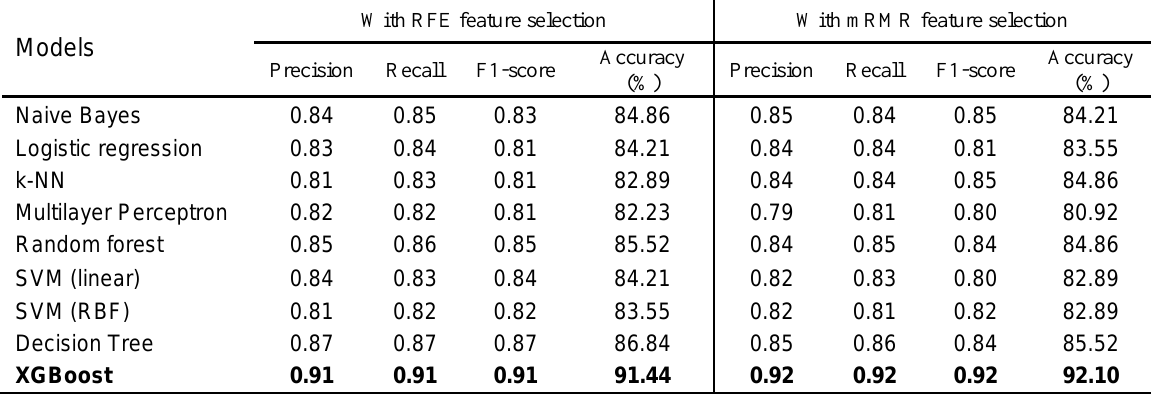
Table 2. All feature subsets except MFCC using RFE and